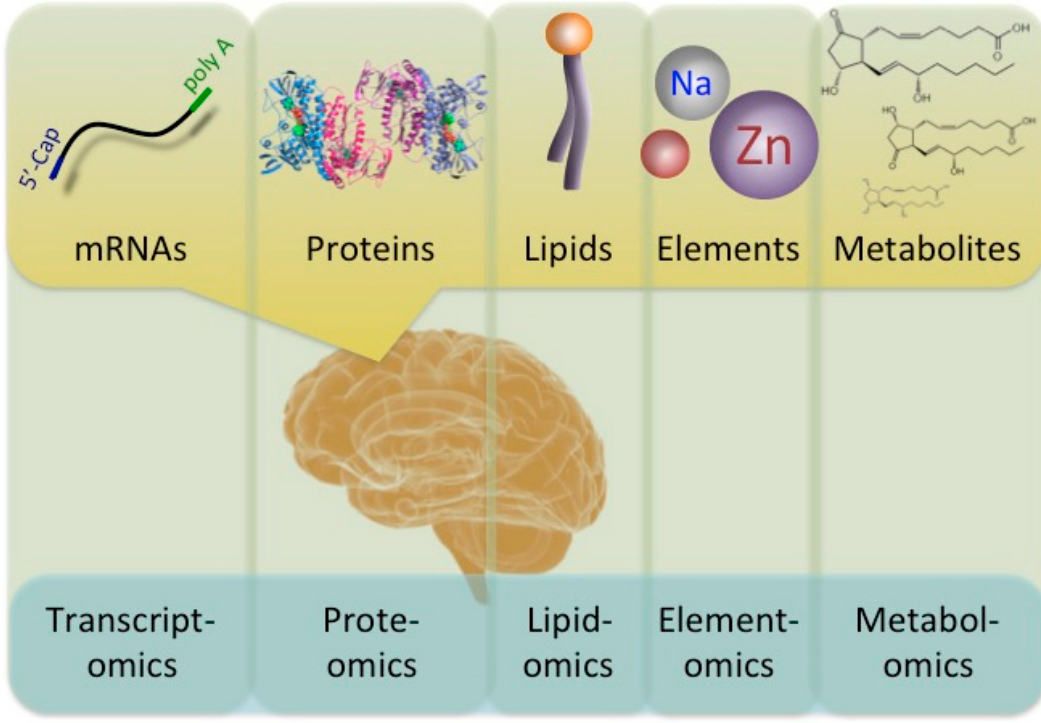
Figure 1. A diagram of the interaction between ‘-omics’ and the flow of biological molecules. A number of ‘-omics’ analyses have been developed. Transcriptomics, proteomics, lipidomics, elementomics, and metabolomics analyses describe the levels of mRNA, proteins, lipids, such as phospholipids, elements, such as trace biometals, and various metabolites, such as prostaglandins, respectively.